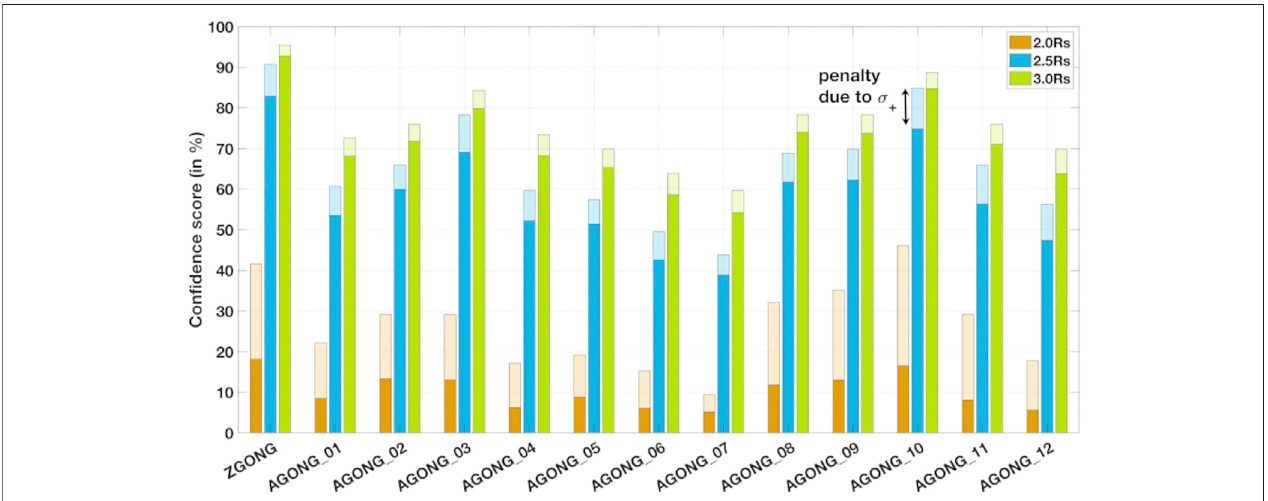
FIGURE 5 | Summary plot of PFSS models performances according to WL, using GONG/mrzqs (labeled “ ZGONG ” ) and GONG/ADAPT (labeled “ AGONG_XX ” )